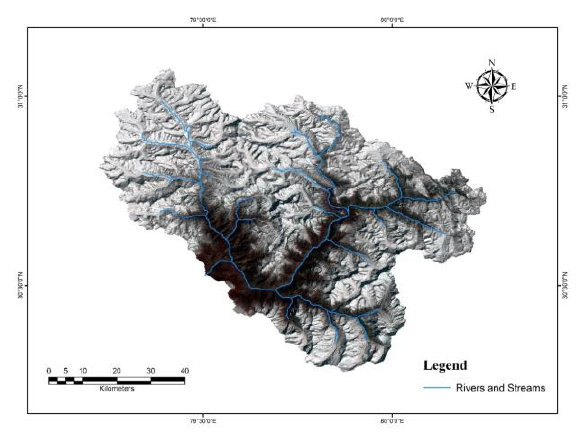
Figure 2 Alaknanda Basin shown on FCC image of Sentinel-2